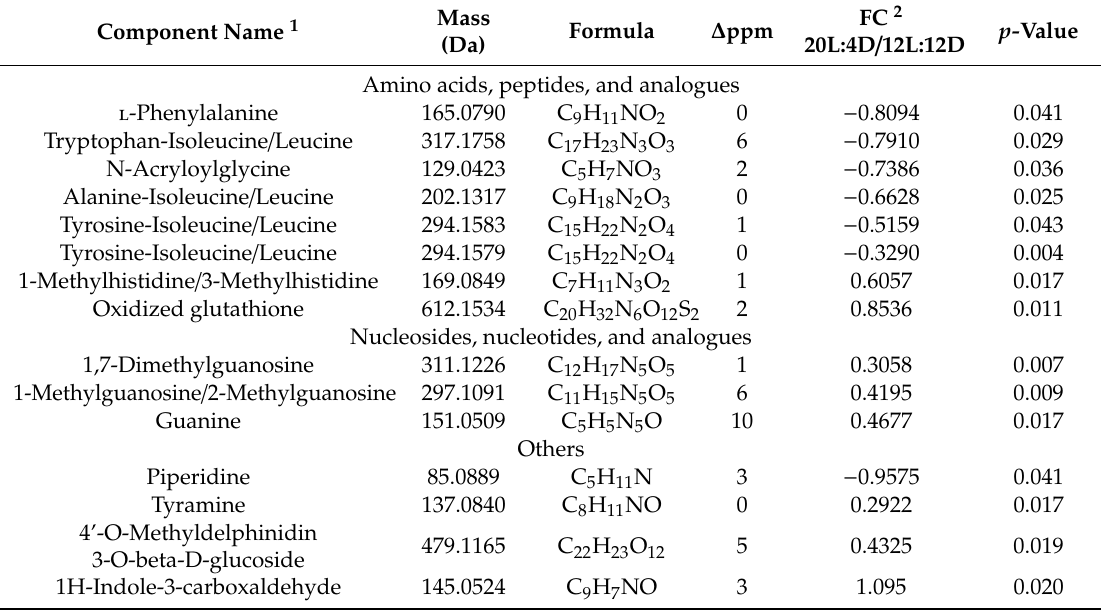
Figure 1. PCA modeling based on the 20 metabolites present within the broiler fillet ( M. Pectoralis major ) muscles were found to be di ff erent ( p < 0.05) between the 20L:4D and 12L:12D photoperiod treatment groups ( n = 5 / treatment). Table 7. Metabolites significantly di ff erent between the 20L:4D and 12L:12D photoperiod treatments ( n = 5 /